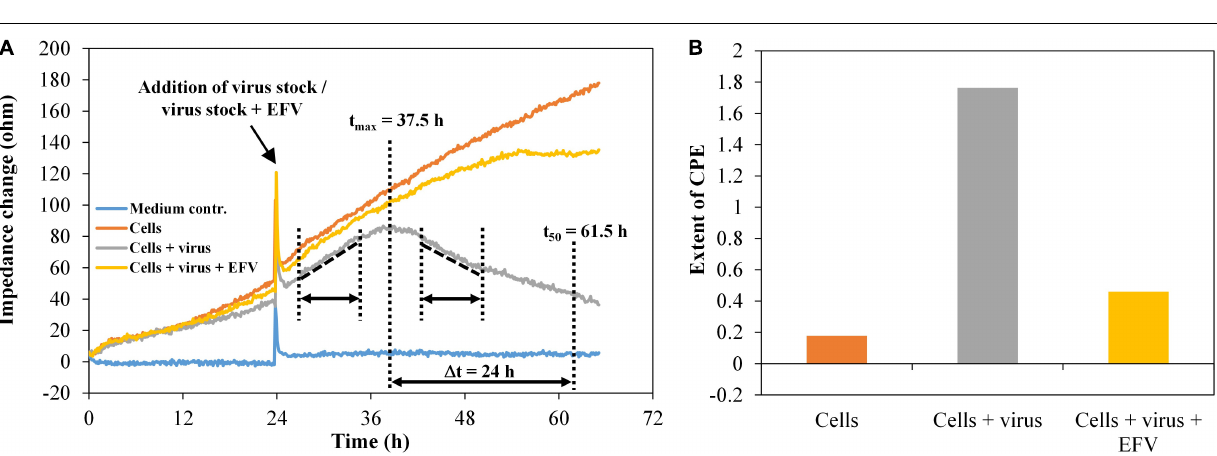
FIGURE 7 | TZM-bl cells, exposed to HIV-1 pseudovirus and antiviral substance efavirenz (1 µ M), n = 2. (A) Impedance curves. All curves were set to 0 (cid:127) at t = 0. The slope of medium average was corrected to 0, and all other curves were modified correspondingly. The dashed and dotted lines in the diagram illustrate the curve regions used to calculate the extent of the cytopathic effect. (B) Extent of CPE without and with antiviral substance efavirenz. Values were calculated, using the time intervals illustrated in (A) and the formula described in section “Fabrication of Graphene-Based